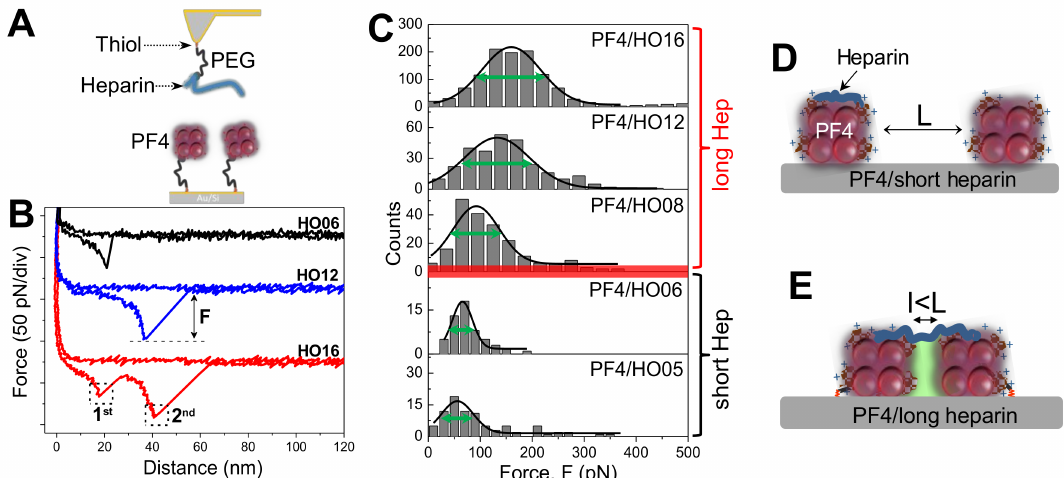
Figure 1. Insights into the interaction between platelet factor 4 (PF4) and heparins of different lengths. ( A ) Single-molecule force spectroscopy (SMFS) setup for measuring binding strength between heparins (blue) of different length immobilized on the tip and PF4 tetramers immobilized on the substrate via polyethylene glycol (PEG) linkers. ( B ) Short heparin (HO06, black) shows only one peak with low binding force (black), longer heparin (HO12, blue) also exhibits one peak with higher binding force (F), whereas longest heparin (HO16, red) displays two rupture peaks (1st and 2nd). ( C ) Gaussian fits of rupture force histograms (solid curves) show narrow widths (green arrows) of the force distributions for short heparins ≤ 6-mer and wider widths for long heparins ≥ 8-mer, suggesting different binding characteristics at 8-mer (red bar). ( D , E ) Models describing different binding pathways of short ( D ) and long ( E ) heparins with two PF4 tetramers away from each other in a distance L. When the AFM tip approaches the substrate, the short heparin binds to one PF4, while long heparin bridges two PF4s and forces them closer to each other in the distance l < L, merging two hydrophobic surfaces (green shaded